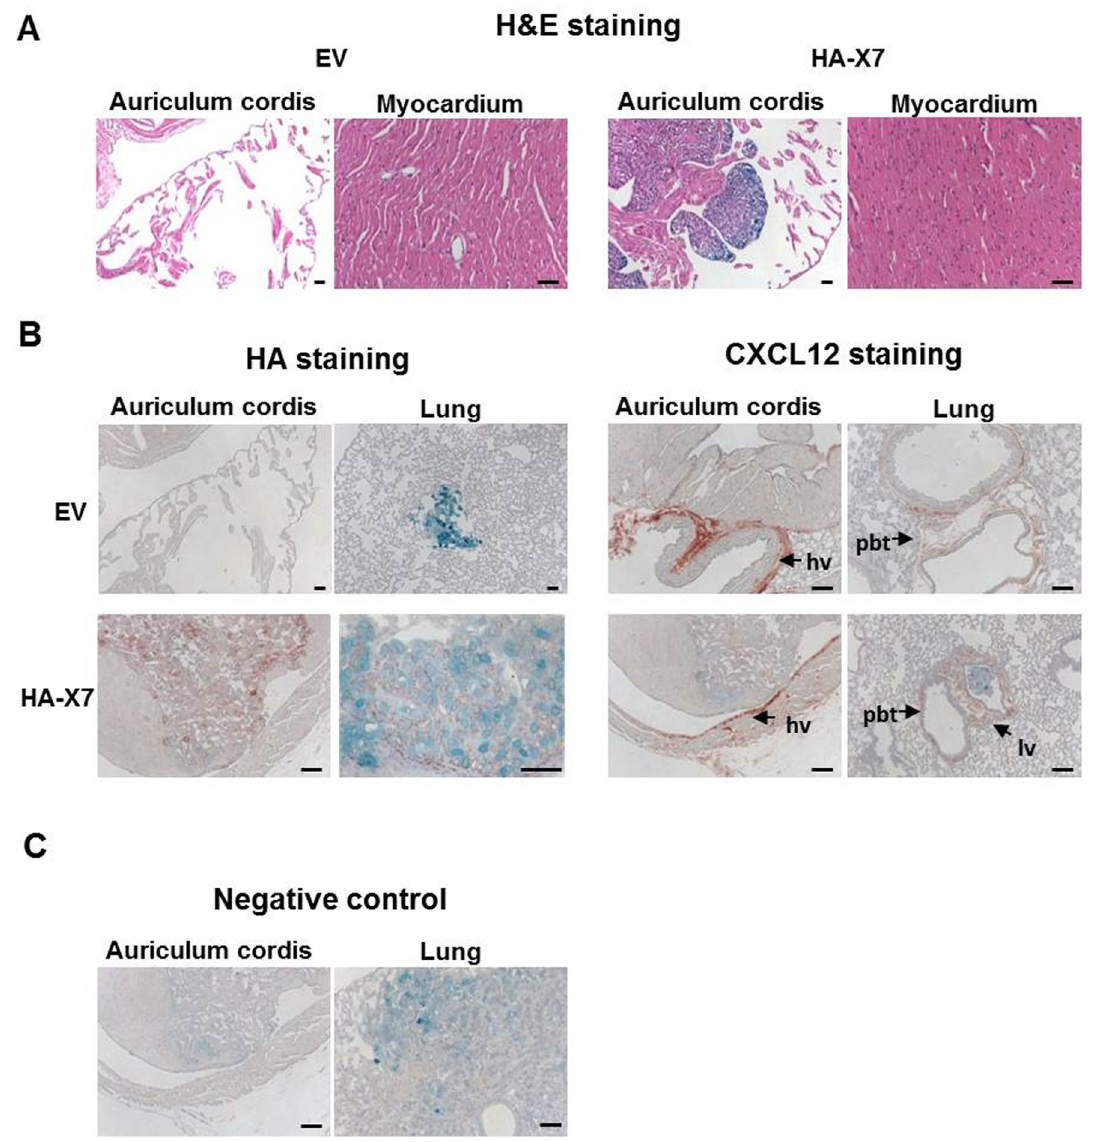
Figure 4. Histology and immunostaining of paraffin sections showed a lower metastatic load in the auriculum cordis and the lung of 143B- LacZ - EV than of 143B- LacZ -HA-X7 cell-injected mice and expression of CXCL12 in both tissues. (A) Representative H&E staining of sections of indicated tissues collected from 143B- LacZ -EV (EV) and 143B- LacZ -HA-X7 (HA-X7) cell injected mice. (B) X-gal (blue) and HA immunostaining of metastatic lesions and immunohistochemical localization of CXCL12 in large vessels of the heart base (hv) region and in lung vessels (lv) and in peribronchial tissue (pbt) of representative paraffin sections of indicated tissues collected from EV and HA-X7 cell-injected mice. (C) Control staining of indicated tissues in the absence of primary HA antibodies. Size bars: 50